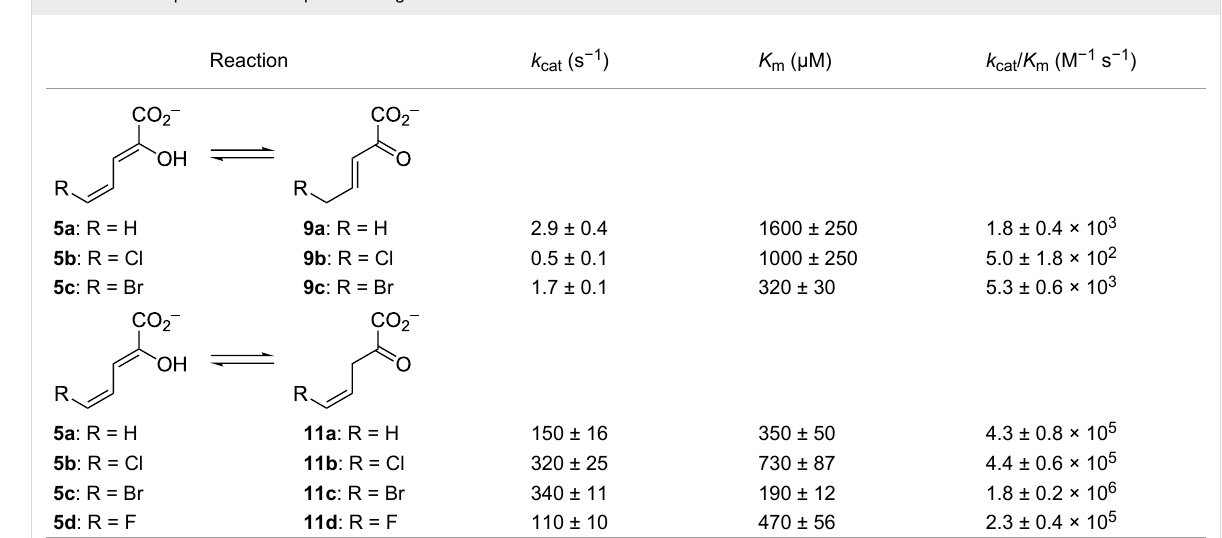
Table 4: Kinetic parameters for Pp 4-OT using 5a–d . a